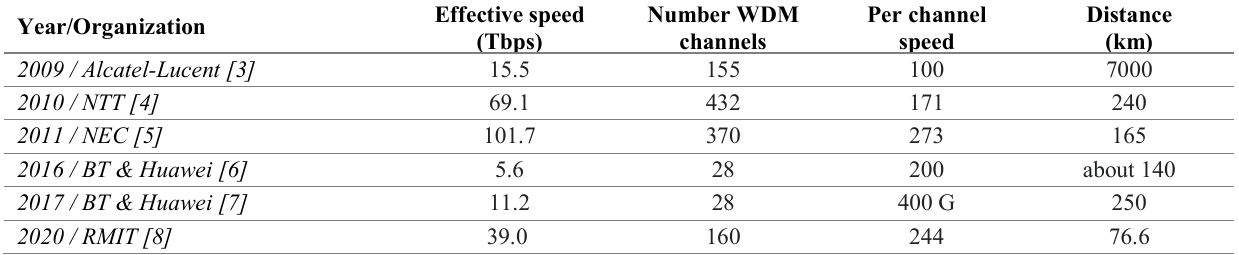
Table 1. Overview of increasing the transmission speed of fiber optic transmission links